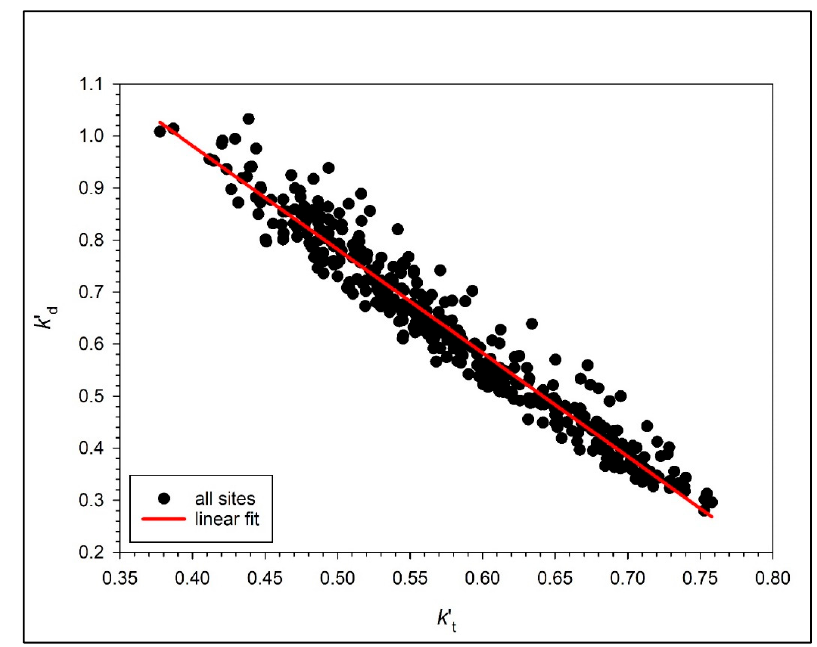
Figure 9. Monthly mean k ’ d vs. k ’ t data pairs for all 33 sites belonging to the four climatic zones under all-sky conditions in TATY and their best-fit line. Linear regression equation: k ’ d = 1.777 − 1.9991 k ’ t , R 2 = 0.94.